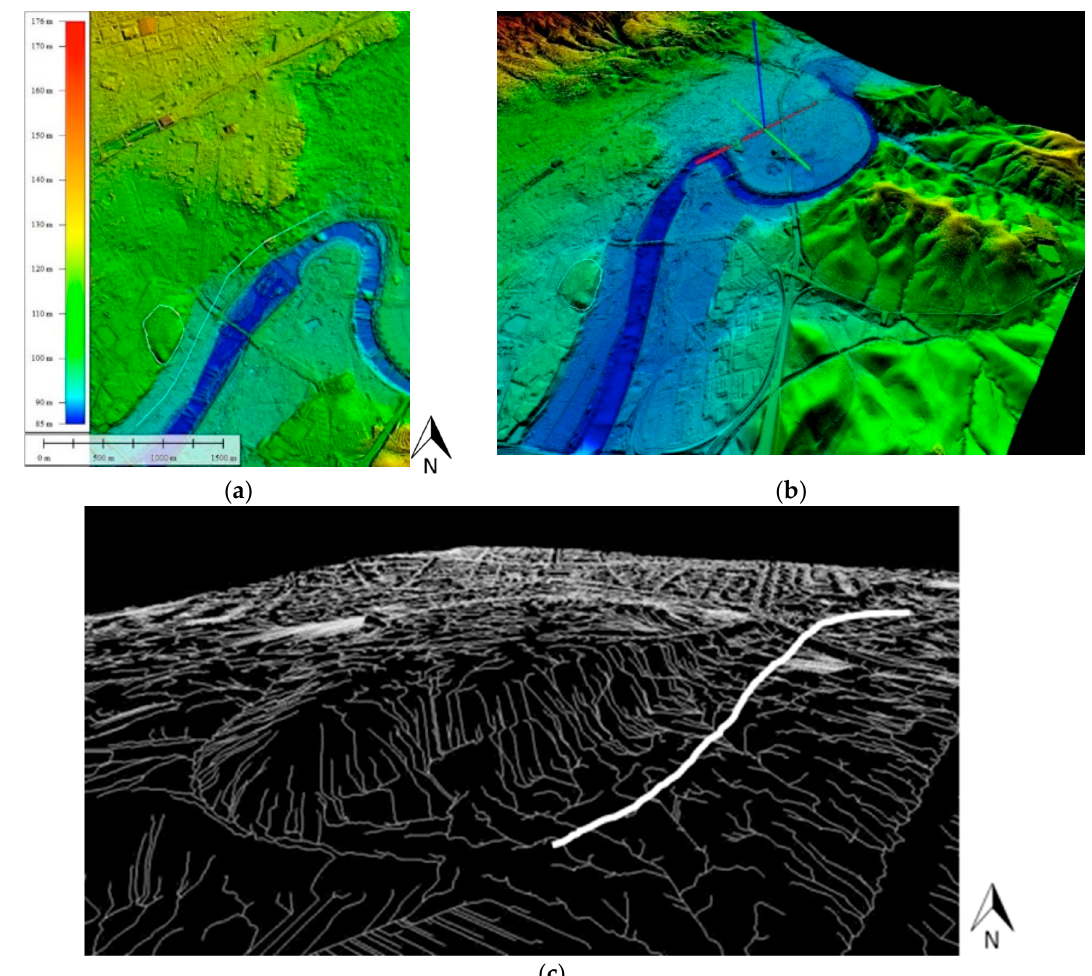
Figure 4. ( a, b ) : Site of pre-Roman Cordoba. An abrupt cliff separates the Iberian city and the old Guadalquivir riverbed. The zone of the hypothetical ancient channel shown in Figure 4c is marked with white lines. DEM from LAS. files. The ©PNOA-LiDAR 2016 CC-BY 4.0 ign.es files were processed with the Global Mapper 18.1 atlas shader hillshade and the 3D model was developed by Antonio Monterroso-Checa. Vertical exaggeration in 3D model: 2.75. Coordinates in the central axis of the image: 37°52´20´´, 4°47´22”. ( c ) Settlement and cliff of Iberian Cordoba. The 3D analysis of hydrographic basins with +2.75 points of vertical exaggeration shows the riverbed slopes in the direction of the ancient Guadalquivir River channel (white line). Image generated from LAS files. The ©PNOA-LiDAR 2016 CC-BY 4.0 ign.es files were processed with Global Mapper 18.1 by Antonio Monterroso-Checa.